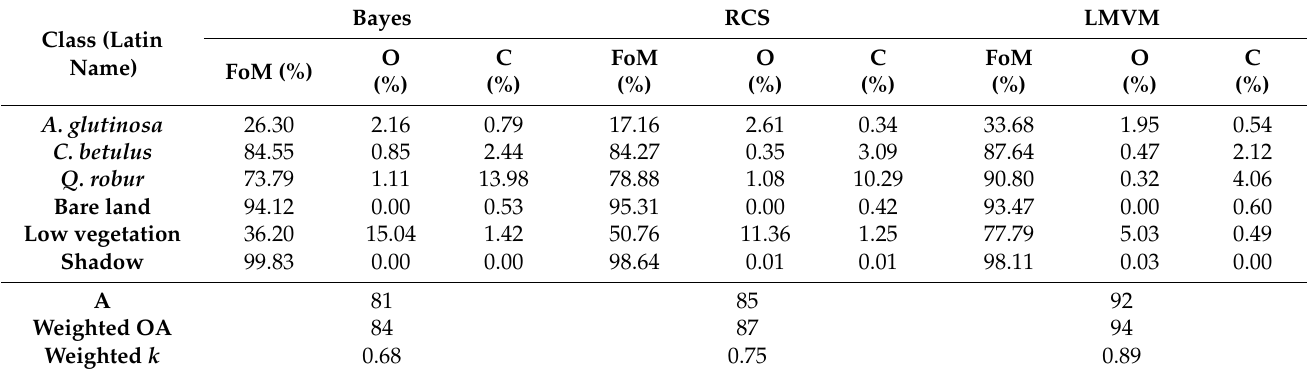
Table 3. Extended accuracy assessment of pixel-based classification of the pansharpened imageries (Bayes, RCS, LMVM). Class